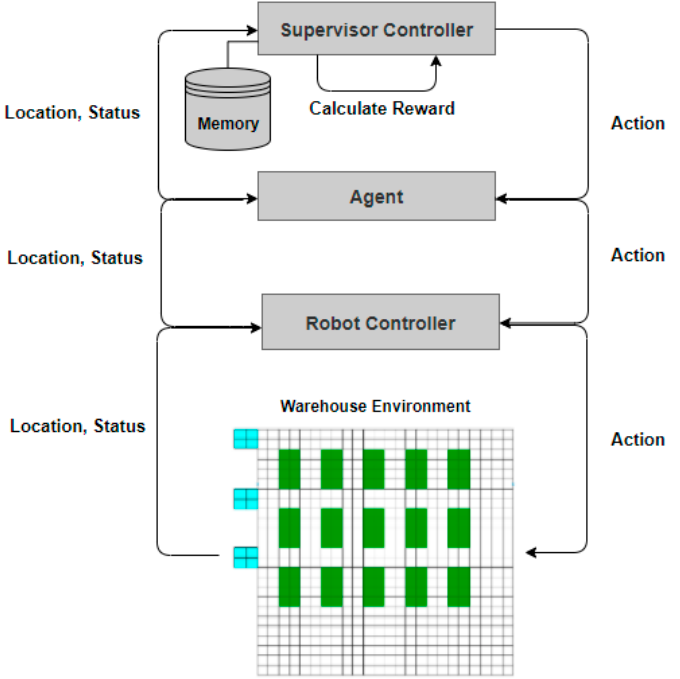
Figure 6. Warehouse mobile robot framework structure.